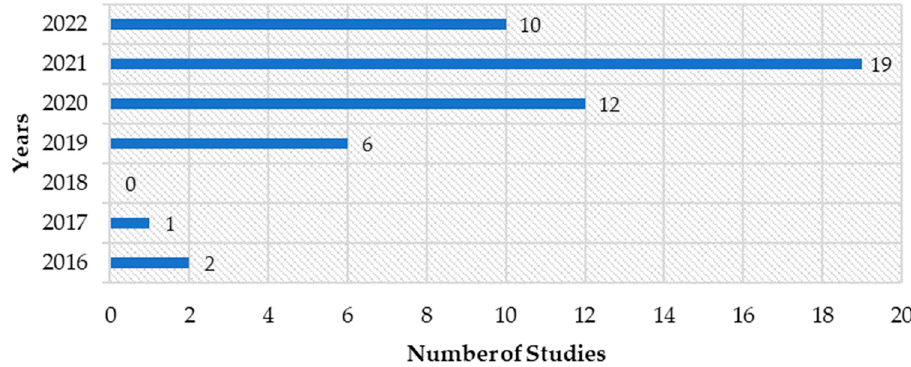
Figure 2. The annual number of selected primary studies on remote sensing and cloud computing- based studies of wetland monitoring.